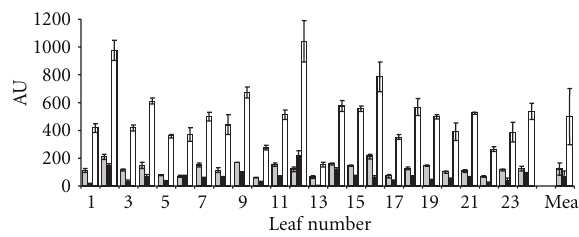
Figure 2: Histogram representing the contents (arbitrary unity) in caftaric acid (grey), chlorogenic acid (black), and chicoric acid (white) for each of the 24 di ff erent leaves analyzed by four inexperienced testers. The di ff erences obtained between the manipulators are showed by the standard deviations (no significant di ff erences; see Table